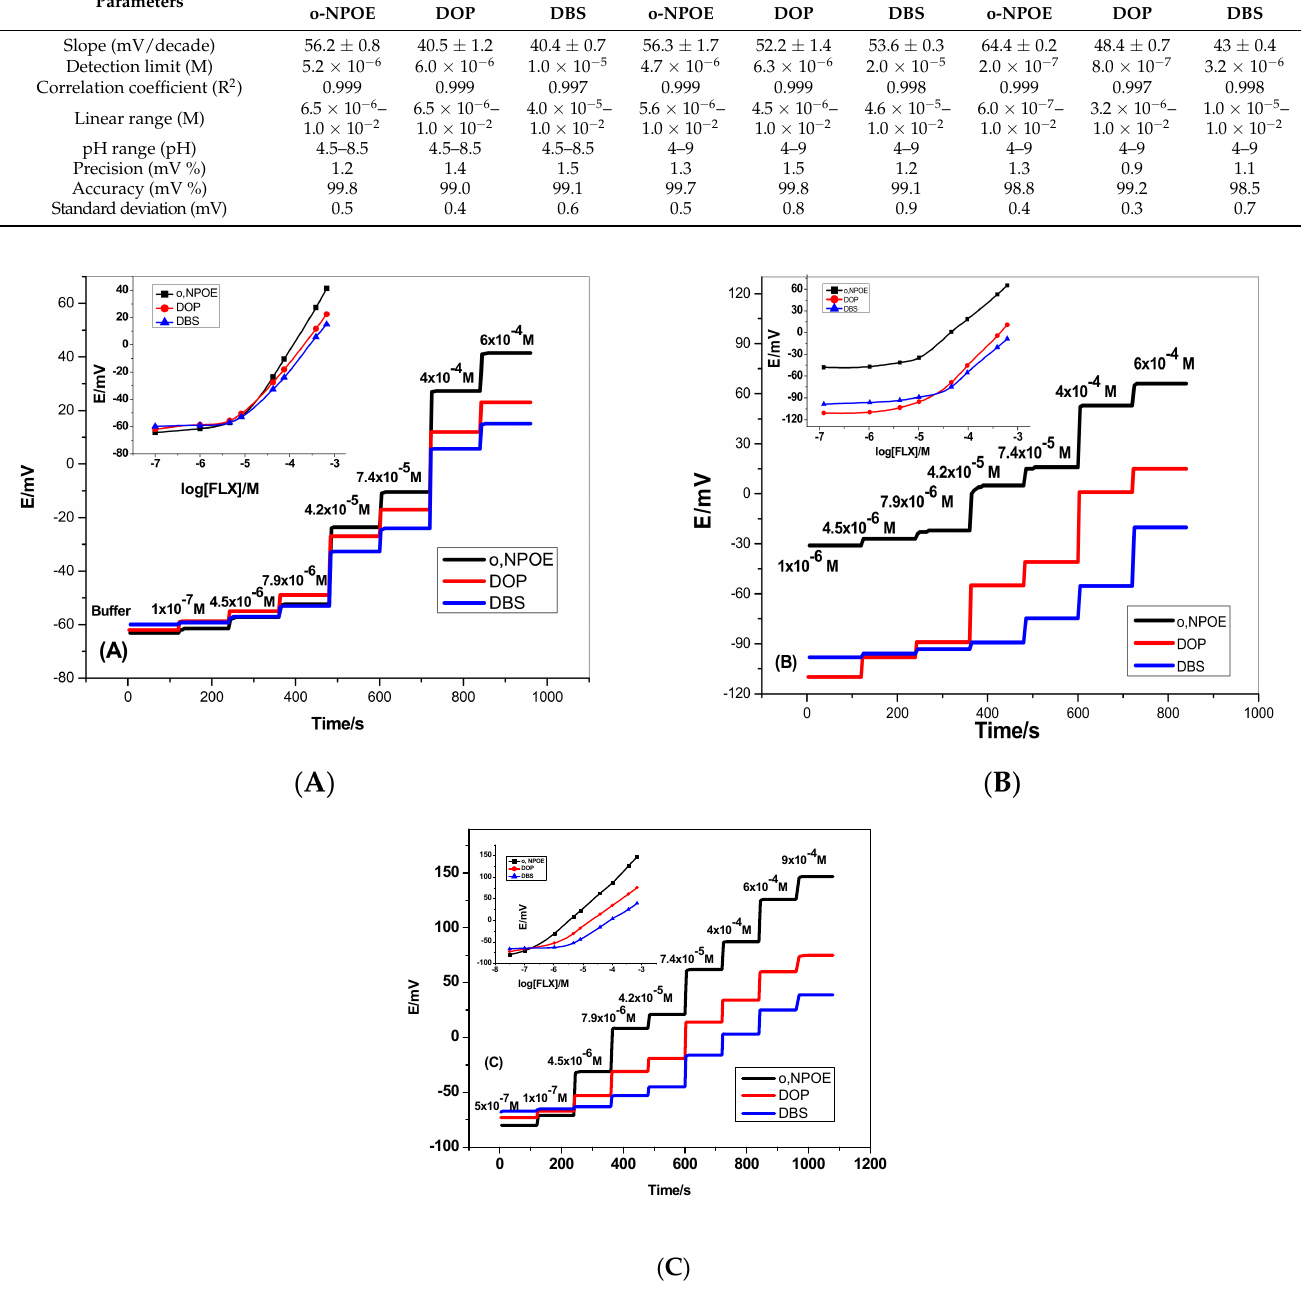
Figure 1. Time-trace versus FLX concentration for sensors based on ( A ) ionophore I ( B ) ionophore II; ( C ) ionophore III; using o-NPOE, DOP and DBS as membrane solvent mediators. (Inset: calibration plot).